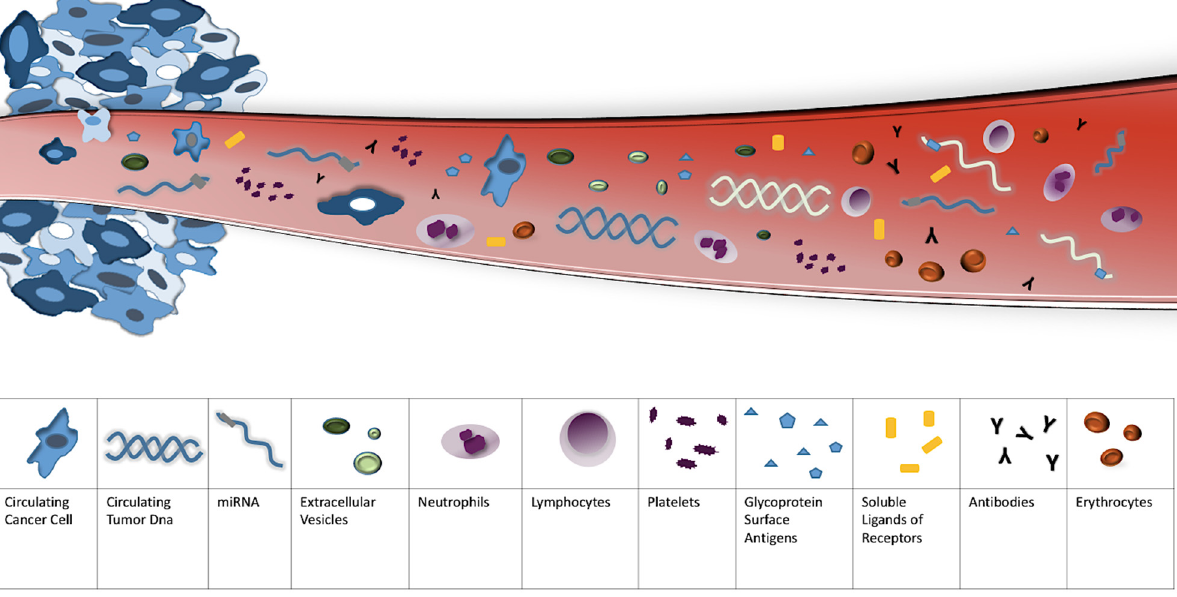
Figure 2. Circulating biomarkers in PtR OC.